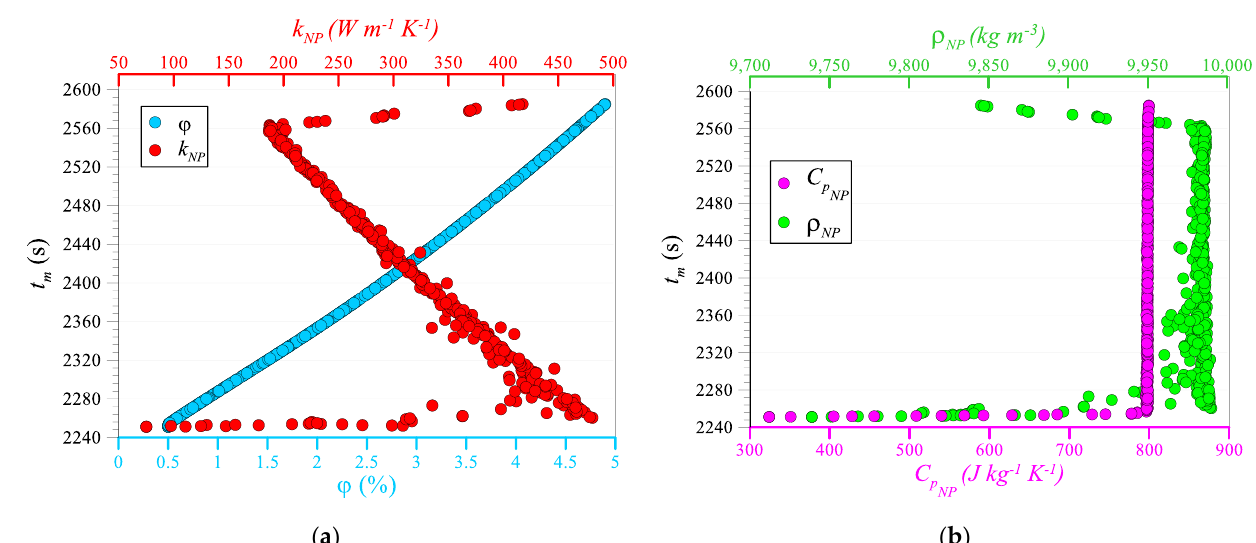
Figure 10. Optimal variation of melting time ( 𝑡 𝑚 ) with respect to ( a ) volume fraction and thermal conductivity, ( b ) specific heat and density.